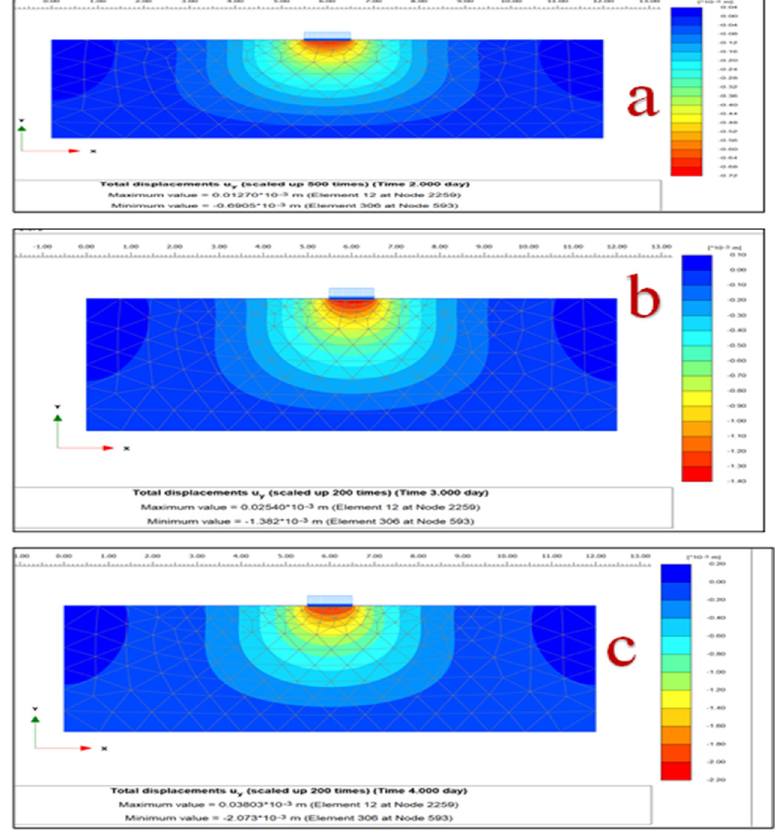
Figure 3. Settlement of the footing under a load of ( a ) 12, ( b ) 24, and ( c ) 36 kPa.